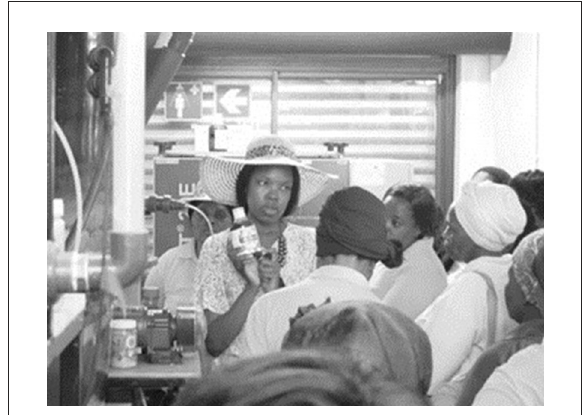
FIGURE3 Community stakeholders visit the processing facility and speak with Lungi Zuma, local manager and environmental engineer at the Newlands Mashu Research Station. Source: Ben